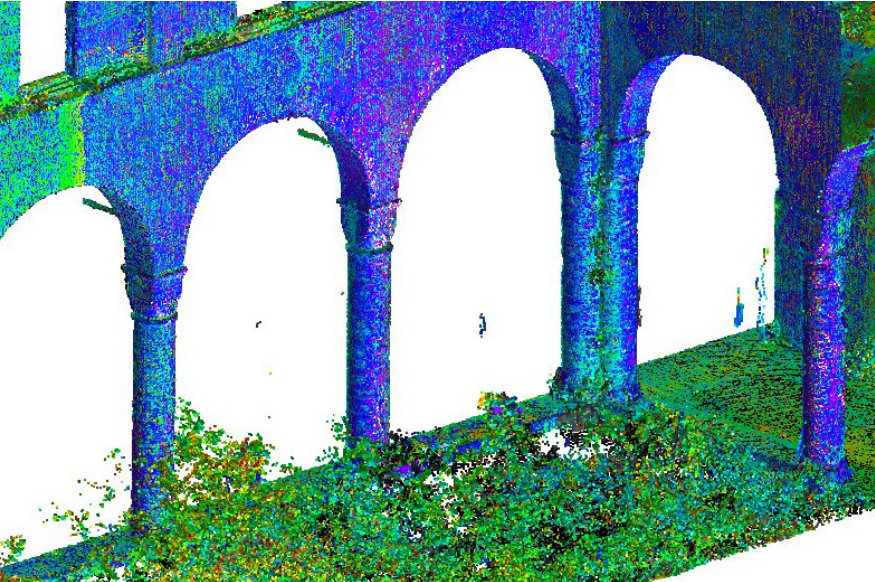
Figure 4. A particular column that could divided into basement, column shaft and capital.